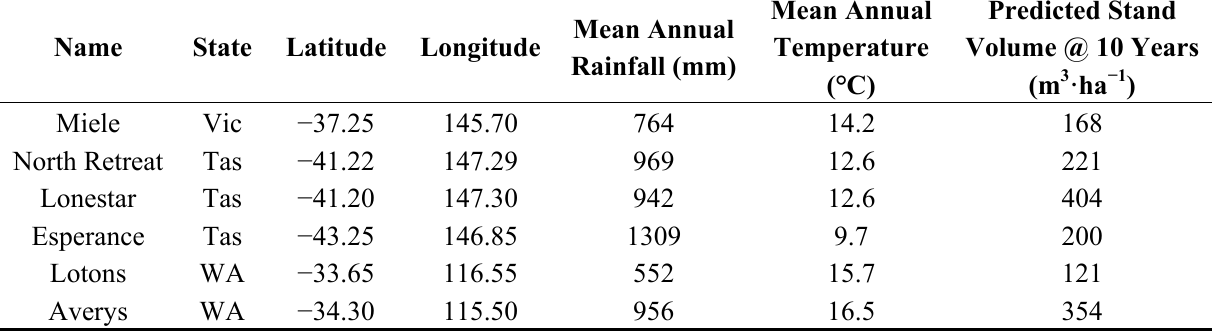
Table 1. Names and grid references of the E. globulus sites used for the prediction of pest impacts on C sequestration under current and changing climate. Long-term (1961–1991) mean annual rainfall (mm) and mean annual temperature (°C) and entire stand volume at age 10 years are also